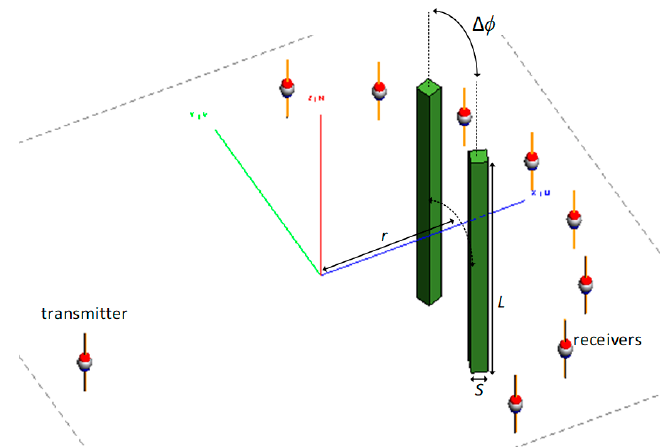
Figure 7. FEKO simulation model for the first 3D imaging example. The transmitter-receivers configuration, number of antennas, properties of the background and objects are similar to those in Figure 2. The objects are two cuboids with square cross-section of size S = 4 mm and height of L = 67.5 mm. The angular separation between the cuboids is ∆ φ = 40 and they are placed at radius of r = 36 mm.